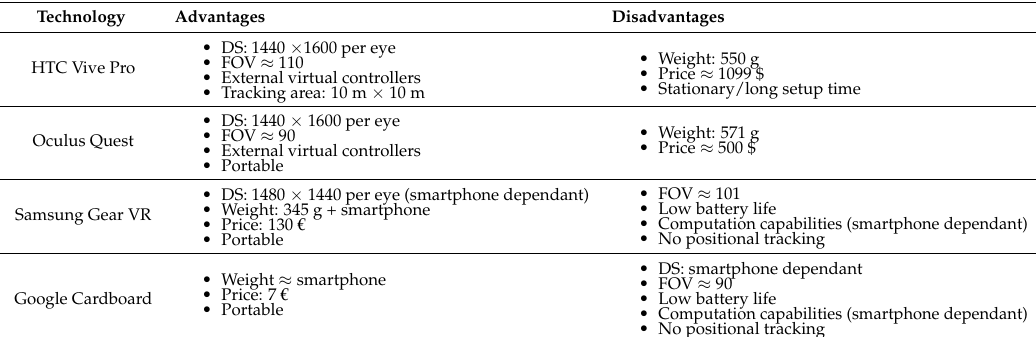
Table 1. Comparison of the most popular models of head mounted display systems for virtual reality (VR) used for educational